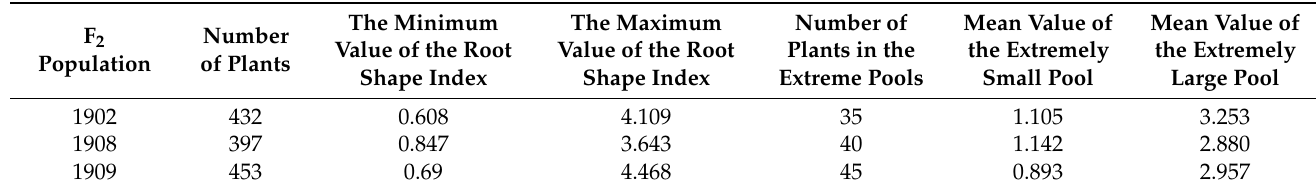
Table 2. Information on the mixed pools and phenotypic data for the three F 2